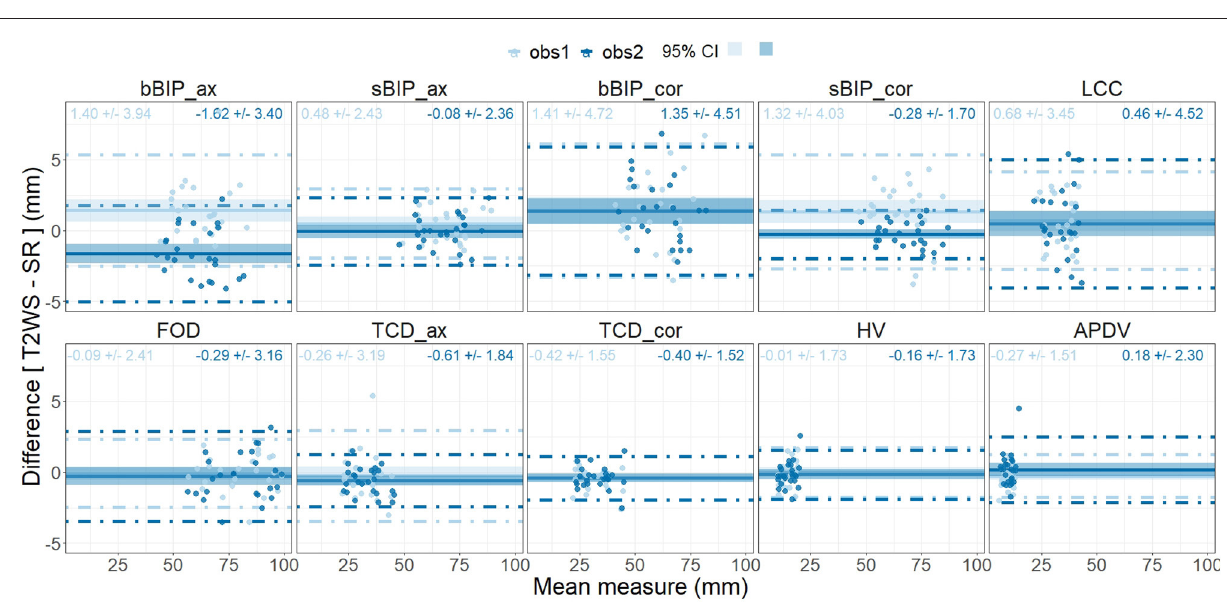
FIGURE 6 | Bland–Altman plots of measurement differences between datasets [inter-dataset, T2-weighted sequence (T2WS) vs. super-resolution (SR)] for observer 1 and for observer 2 (intra-observer) for each biometric measurement. Each point corresponds in the x-axis to the mean measure between datasets for each observer (light blue for observer 1, dark blue for observer 2) and on the vertical y-axis to the difference between the two measurements T2WS/SR in mm. Horizontal solid line = mean of all measurement differences. Dashed lines = 95% limits of agreement, and shadow areas correspond to the 95% confidence interval